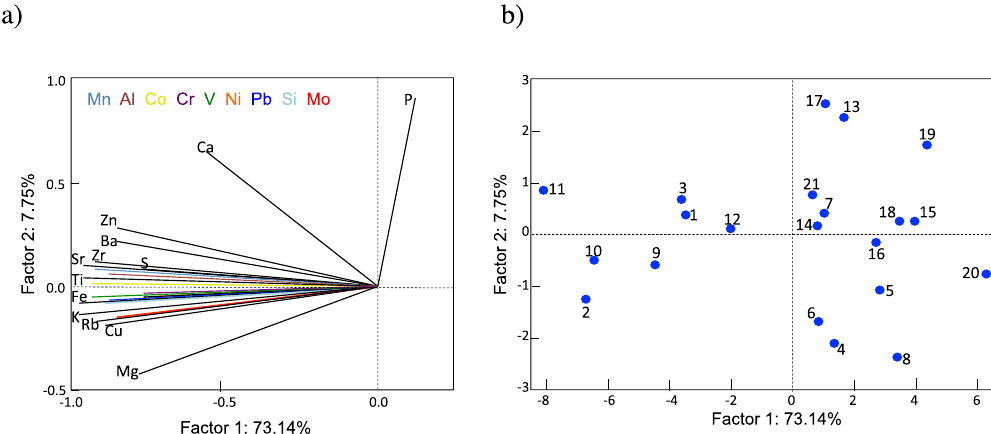
Figure 4. Principal component analysis (PCA). Plots generated by using STATISTICA (data analysis software system, version 7, http://www.statsoft.com/Products/STATISTICA-Features) 38 . ( a ) Projections of elements on the factor-plane. ( b ) Projections of sites on the factor-plane; numbers identify the 21 sampling sites indicated in Table 1.